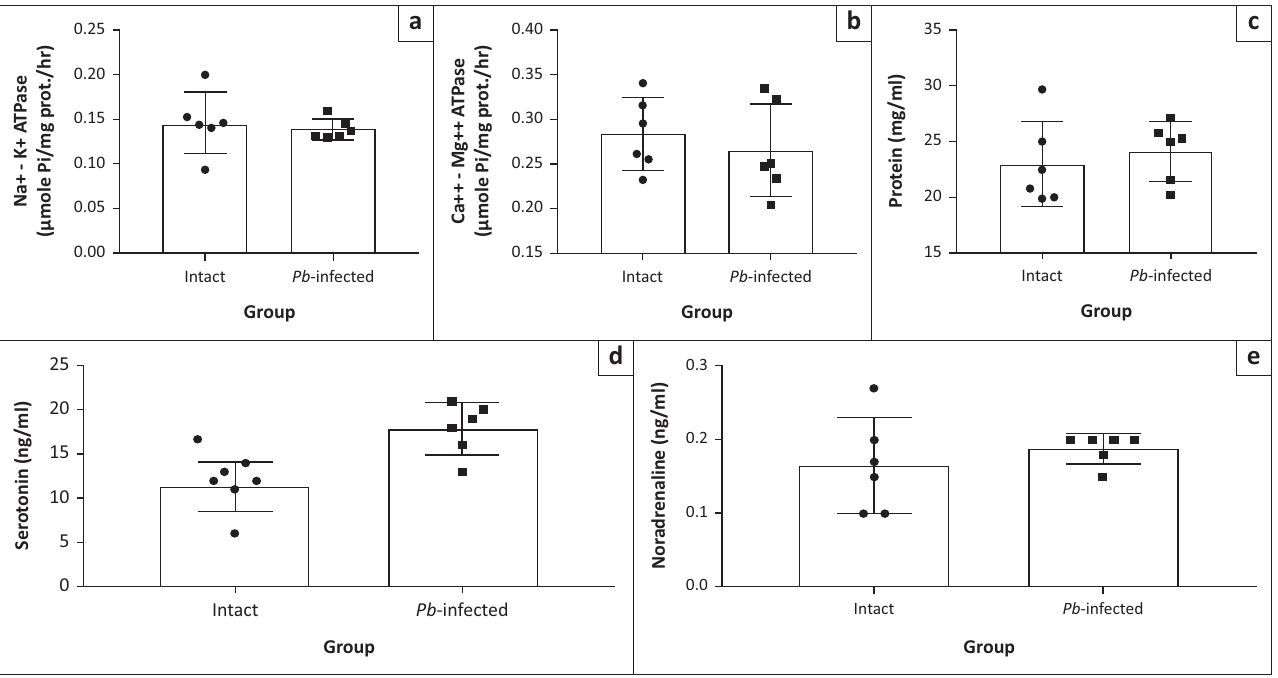
FIGURE 8: Biochemical changes in the brain of Pb -infected Swiss mice. (a) and (b) Brain activities of Na + – K + ATPase and Ca 2+ – Mg 2+ ATPase, respectively. (c) Total brain protein level. (d) and (e) Levels of serotonin and noradrenaline in the brain, respectively.